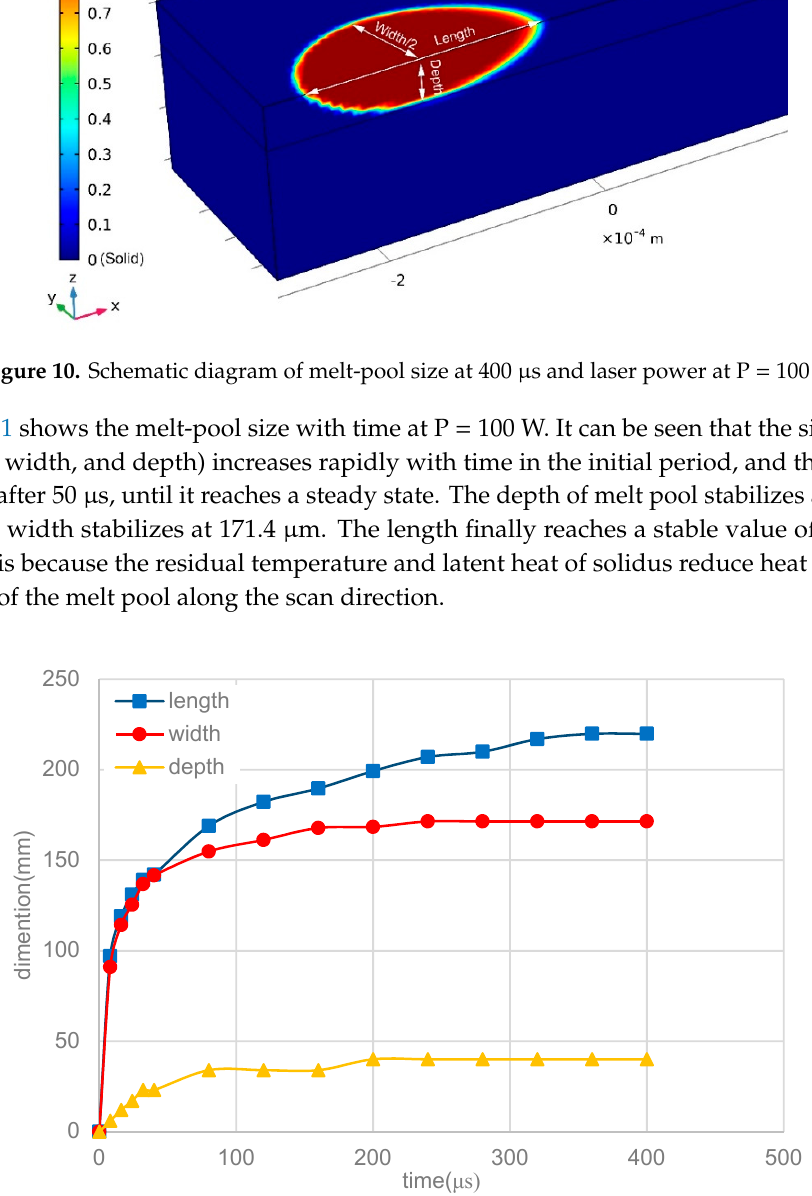
Figure 11. Melt-pool size with time at P = 100 W.